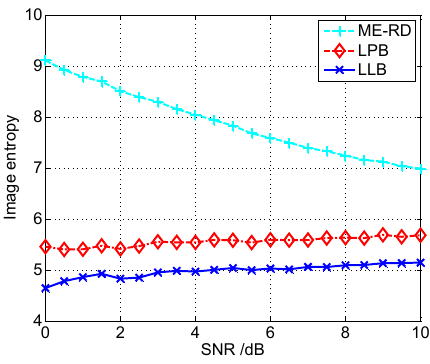
Figure 9. Comparison of image entropy curves versus SNR for different